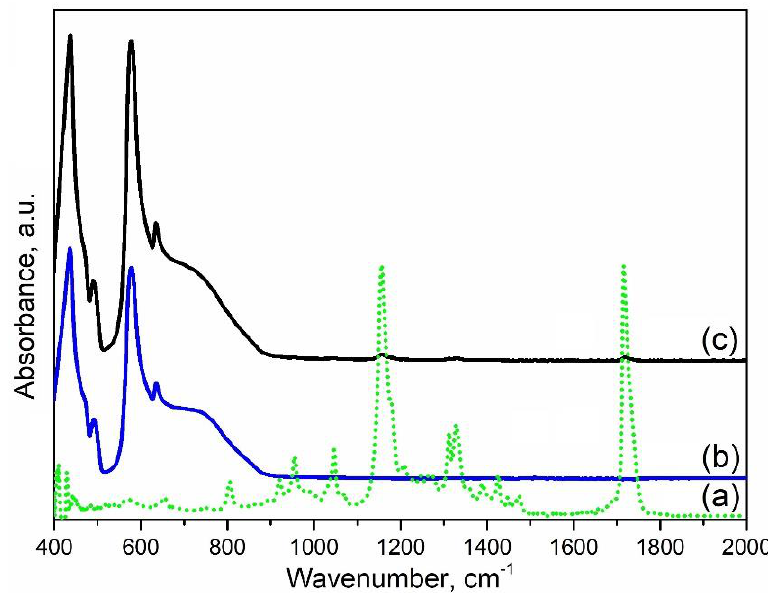
Figure 4. FTIR spectra of raw powders of PLA ( a ), alumina ( b ) and 50Al 2 O 3 /50PLA mixture ( c ). To obtain interpretable data on the viscoelasticity of materials, measurements must be made in the linear viscoelastic range. Figure 5 shows the frequency dependence plots of elastic and loss moduli for the PLA powder at temperatures of 200 °C and 220 °C.